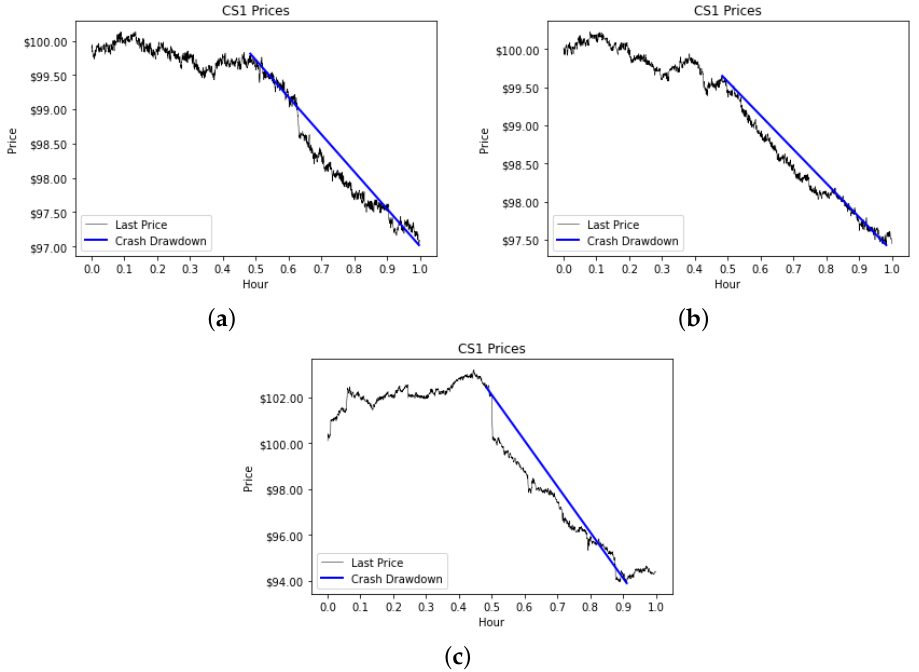
Figure 11. Market drawdown examples in different market types. In all examples, the trading frequency was 0.5 min, the wealth homogeneity was NH, the stress size was 10%, and the stress traders were 20 S. ( a ) CDA. ( b ) FBA (1.0). ( c )